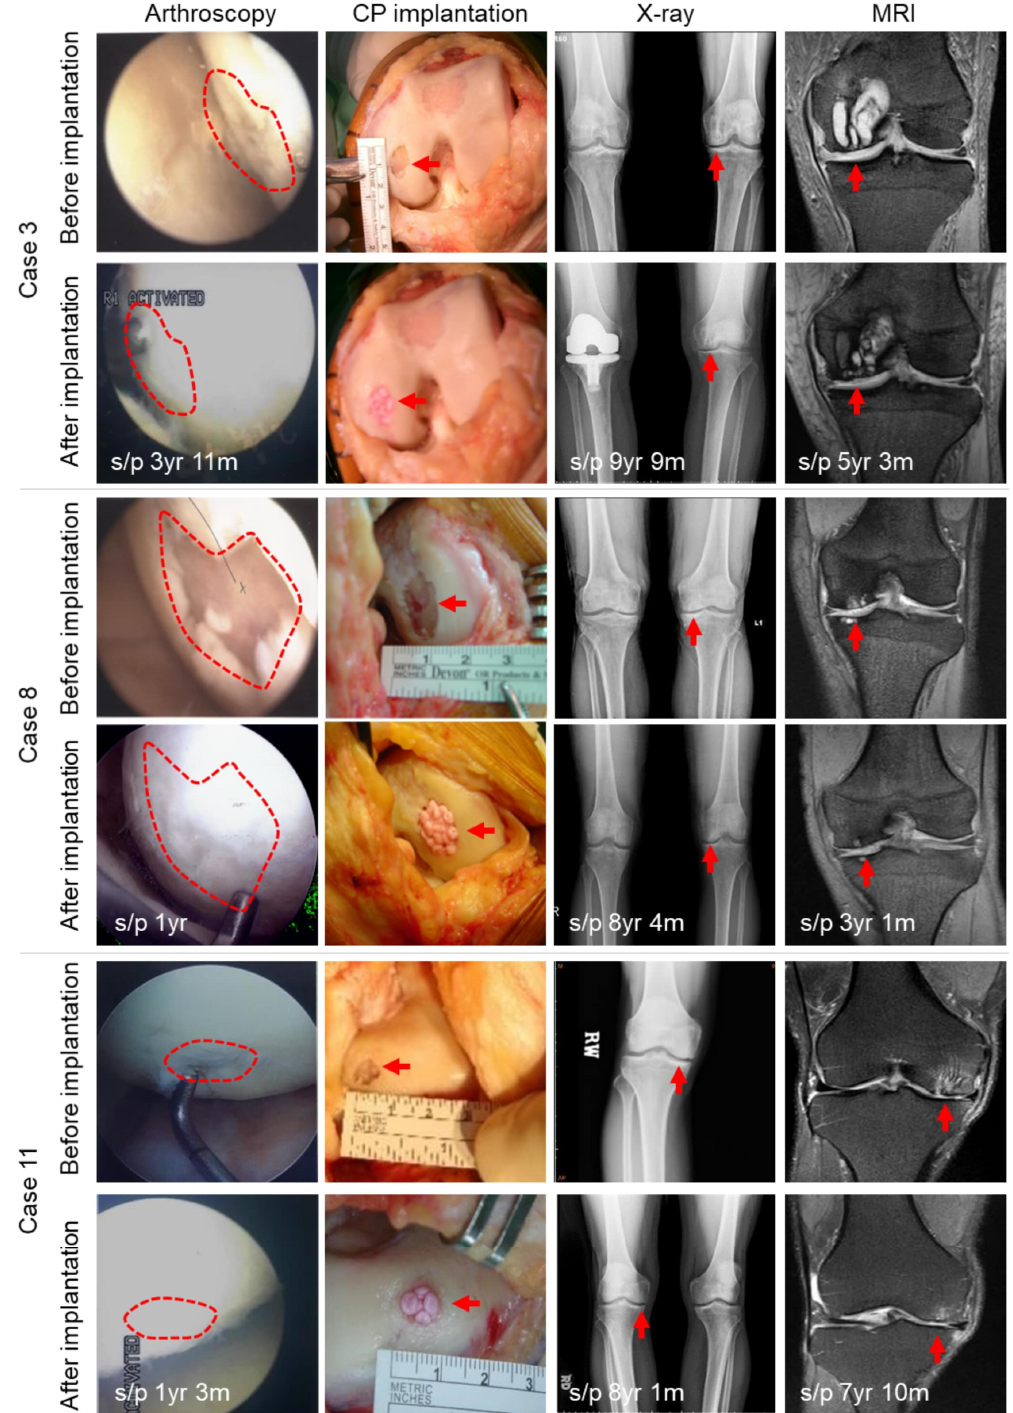
Figure 4. Assessments of the cartilage lesion and recovery before and after the CP implantation. Cartilage lesion as seen via arthroscopy, knee arthrotomy, X-ray, and MRI before and after the CP implantation for three representative patients (Cases 3, 8, and 11). The implanted CP tissue was softer than the native cartilage tissue on palpation with a probe. The defect sites are circled by the red dashed lines in the arthroscopy images and indicated by the red arrows on the other three types of